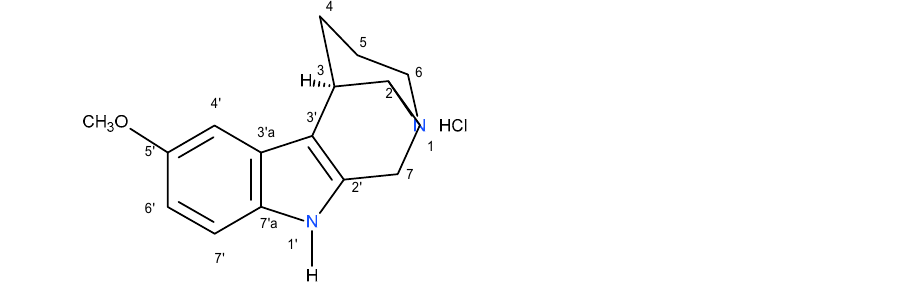
Figure 14. Numbering system for NMR spectra interpretation of compounds (R)- 12c and (S) -13c .